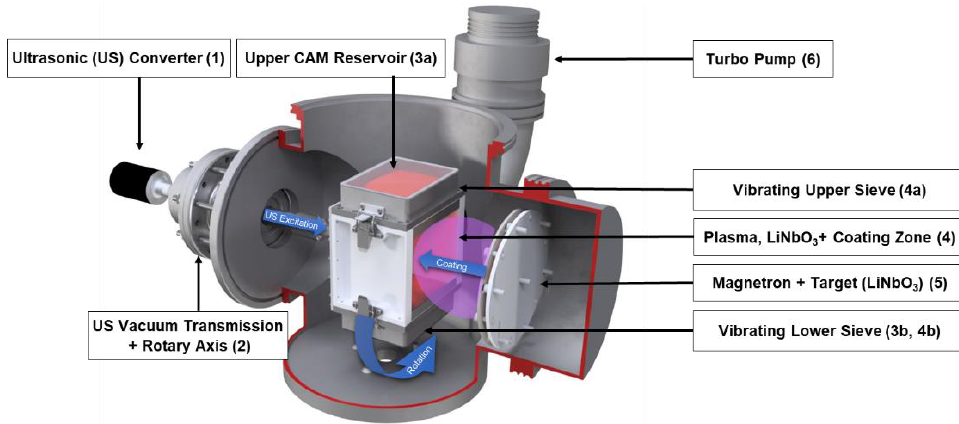
Figure 3. Diagram of the PVD/MS Setup.